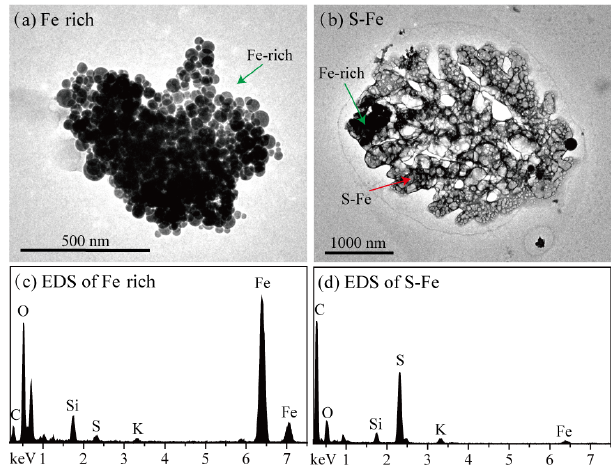
Figure 4. Typical TEM images and corresponding EDS spectra of Fe-rich and S-Fe particles. (a) TEM image of Fe-rich parti- cles. (b) TEM image of S-Fe particles. (c) EDS of Fe-rich particle. (d) EDS of S-Fe particle.